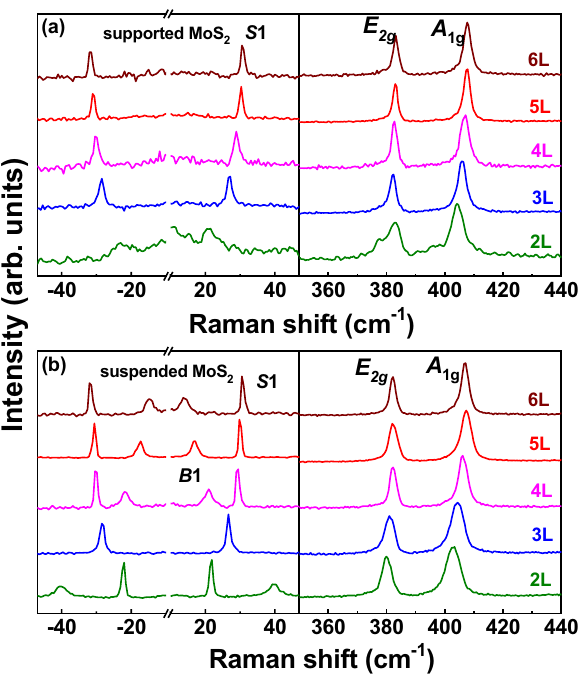
Figure 2. Raman spectra of ( a ) supported and ( b ) suspended MoS 2 with different numbers of layers collected at room